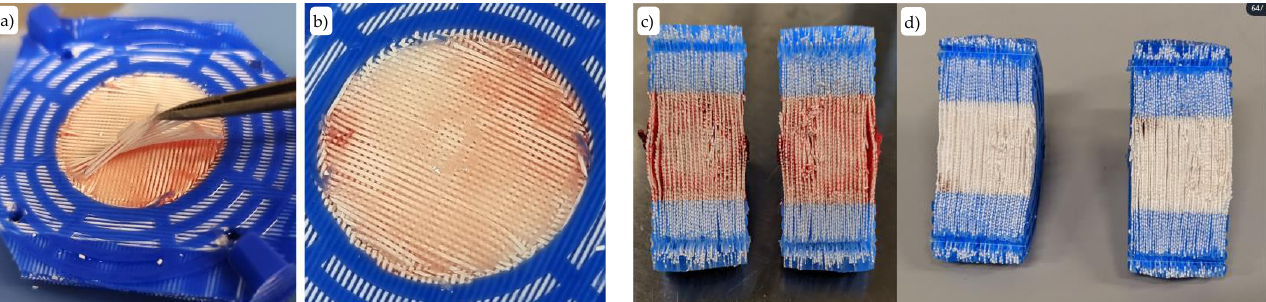
Figure 4. Examples of fiber modules explanted post-experiment for visual inspection. ( a , b ) Fiber bundle cut layer by layer for visual inspection. ( c ) 55-layer fiber module with uncoated PMP fiber mats from a disassembled RatOx oxygenator after an experiment with low-anticoagulated, fresh, whole, porcine blood. The module was cut in a middle plane. ( d ) An identical module with blood from the same donor in the same experiment but with high anticoagulation.